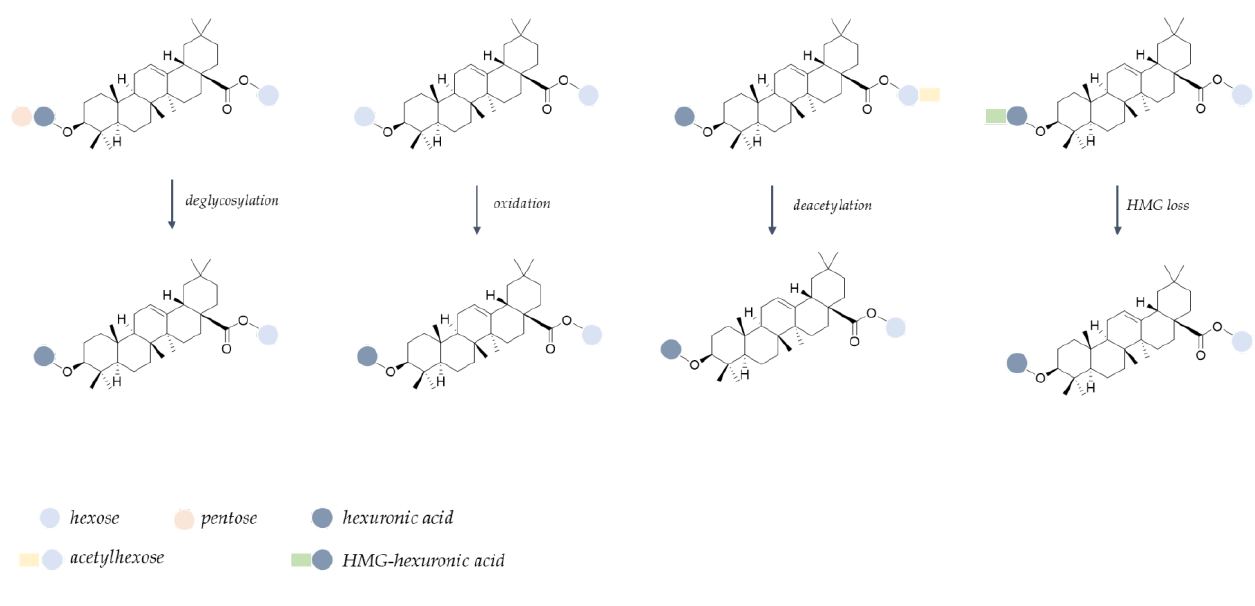
Figure 6. Proposed biotransformation pattern for triterpene saponins during in vitro simulated digestion (HMG = hydroxymethylglutaryl).